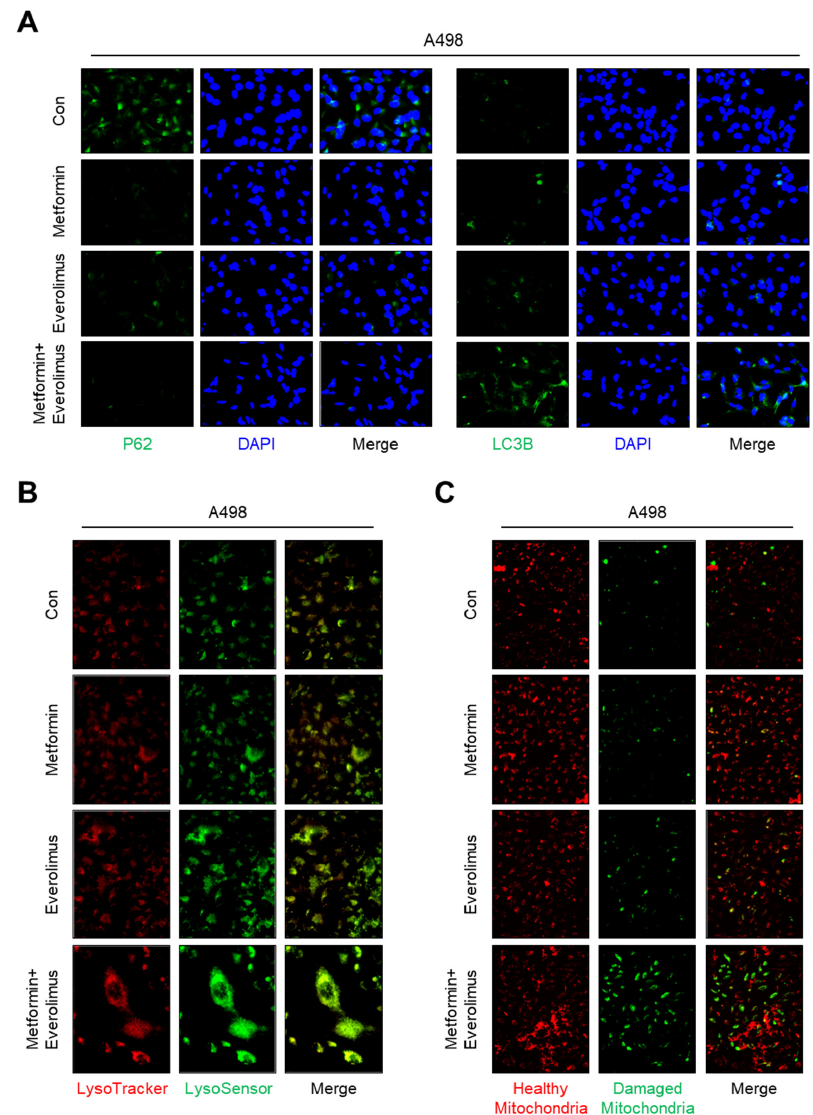
Figure 4. Combination treatment of metformin and everolimus has synergic effects that lead to mitophagy following mitochondrial damage: ( A ) Representative images of immunocytochemistry analysis with anti-P62 (green), anti-LC3B (green), and DAPI (blue); ( B ) Cells were incubated with the drug for 24 h, followed by staining with LysoSensor (green) and Lysotracker (red); ( C ) Fluores- cence images of cells stained with JC-1 after treatment according to the drug options (red; healthy mitochondria and green; damaged mitochondria). 3.6. Synergic Effect of the Combination Treatment on the Mitochondrial Fusion-Fission Cycle in RCC of energy production, we measured the intracellular ATP concentration. The relative ATP